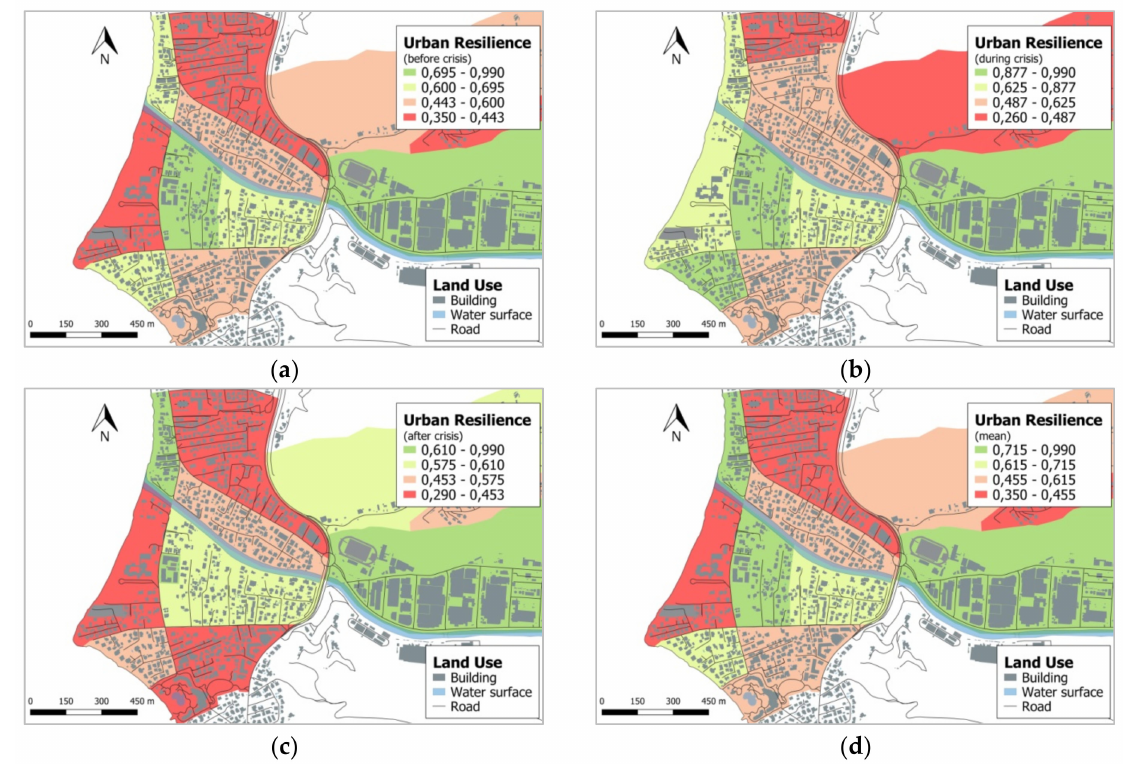
Figure 4. Urban resilience of the Punaruu Valley characterized on the basis of social resilience indicators: ( a ) before, ( b ) during, and ( c ) after a disturbance. ( d ) Average urban resilience.